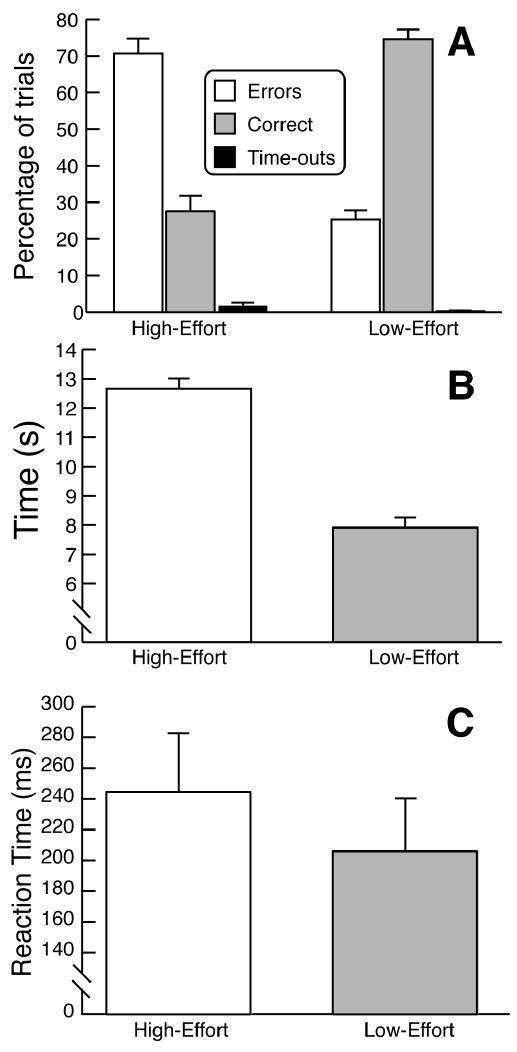
Figure 2. Behavioral Results. (A) Mean percentage of trials that were successful or ended in an error or time-out. (B) Mean task completion time in seconds for the two effort conditions. (C) Mean reaction time in milliseconds for the two different effort conditions.